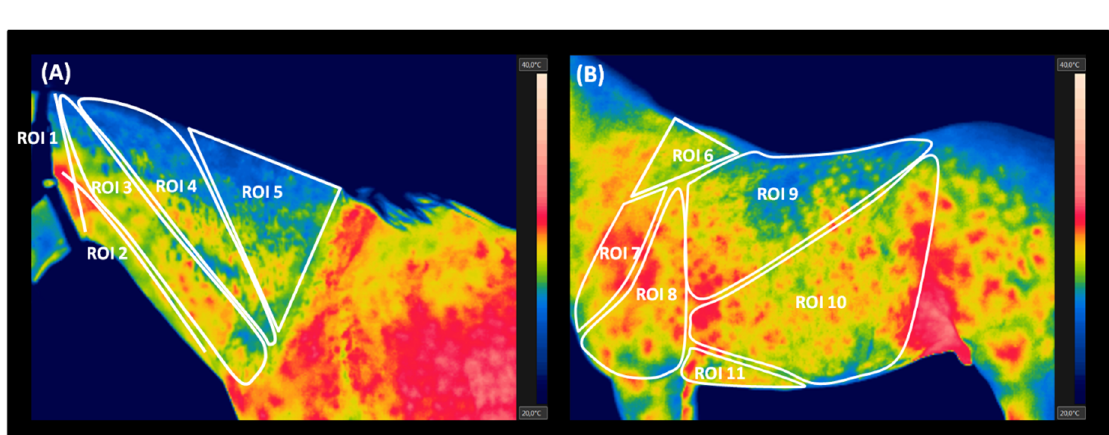
Figure 2. The regions of interest (ROIs) chosen for statistical analysis of the thermographic data. ( A ) The neck area (ROIs of 1–5); ( B ) the trunk area (ROIs 6–11).